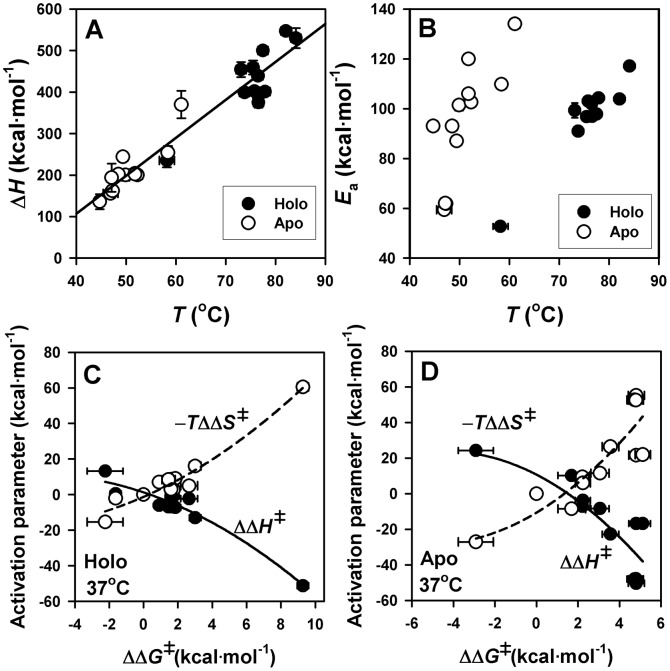
Structure-energetics relationships for thermal denaturion of holo- and apo-AGT enzymes.A) Temperature dependence of denaturation enthalpies (ΔH) for holo- (closed symbols) and apo-(open symbols) proteins. The linear fit provides the value of ΔCp ( = 10.2±0.6 kcal.mol−1). B) Activation energy (E
a) plotted vs. the T
m for holo- (closed symbols) and apo-(open symbols) AGT enzymes. C and D) changes in activation enthalpic and entropic contributions to AGT kinetic stability as a function of changes in activation free energies for holo-(C) and apo-(D) AGT enzymes. Lines in C and D are meant to guide the eye and have no theoretical meaning.